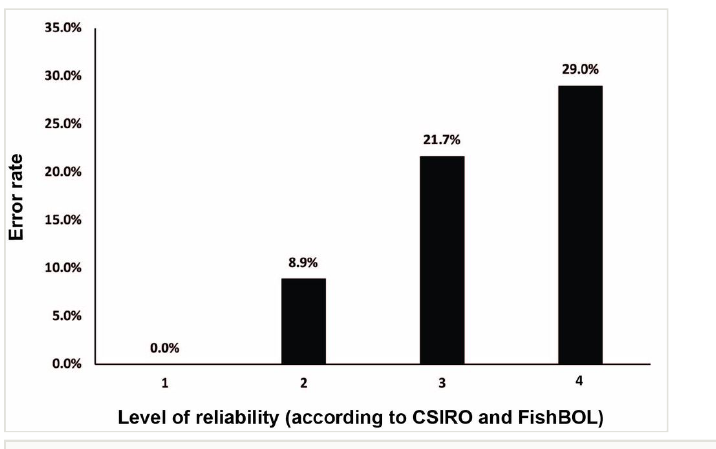
Identi fi cation error rates by level of reliability depending on the taxonomic expertise of the identi fi er involved (in concordance with guidelines of CSIRO and